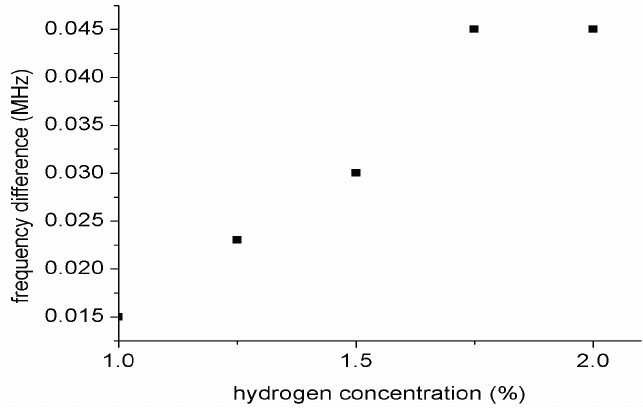
Figure 11. Plot of frequency shift versus hydrogen gas